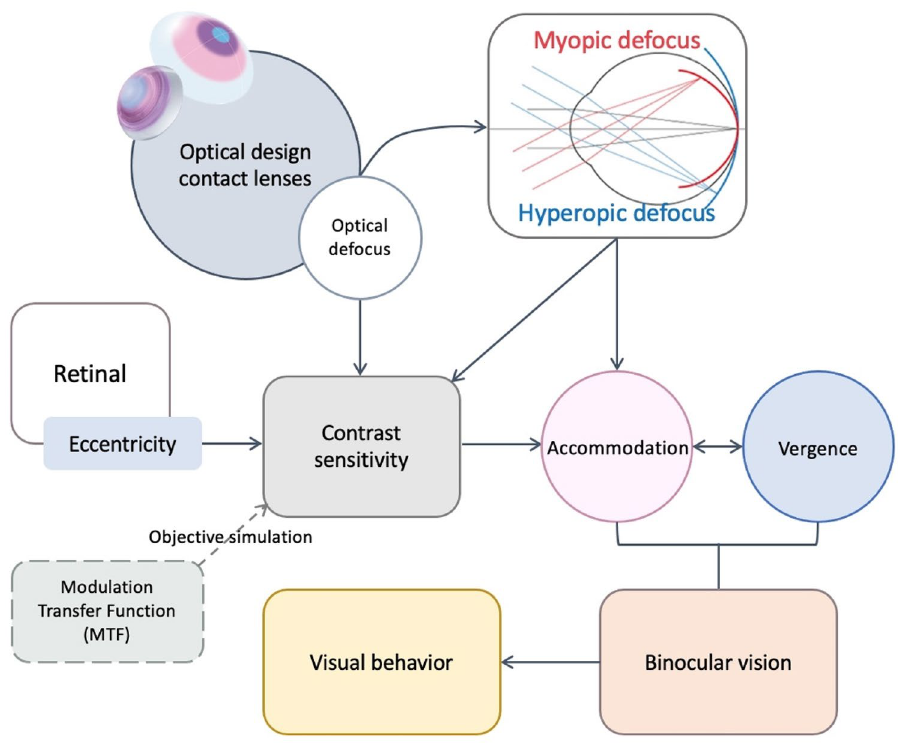
Figure 1. Relationship of Research hypothesis.